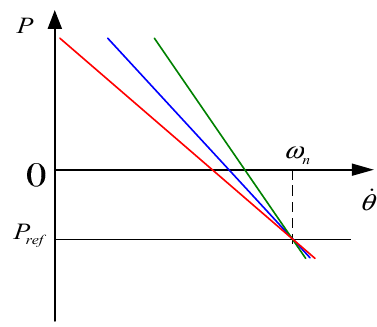
Figure 4. Frequency droop characteristic of the VSM adapts the change of S i.